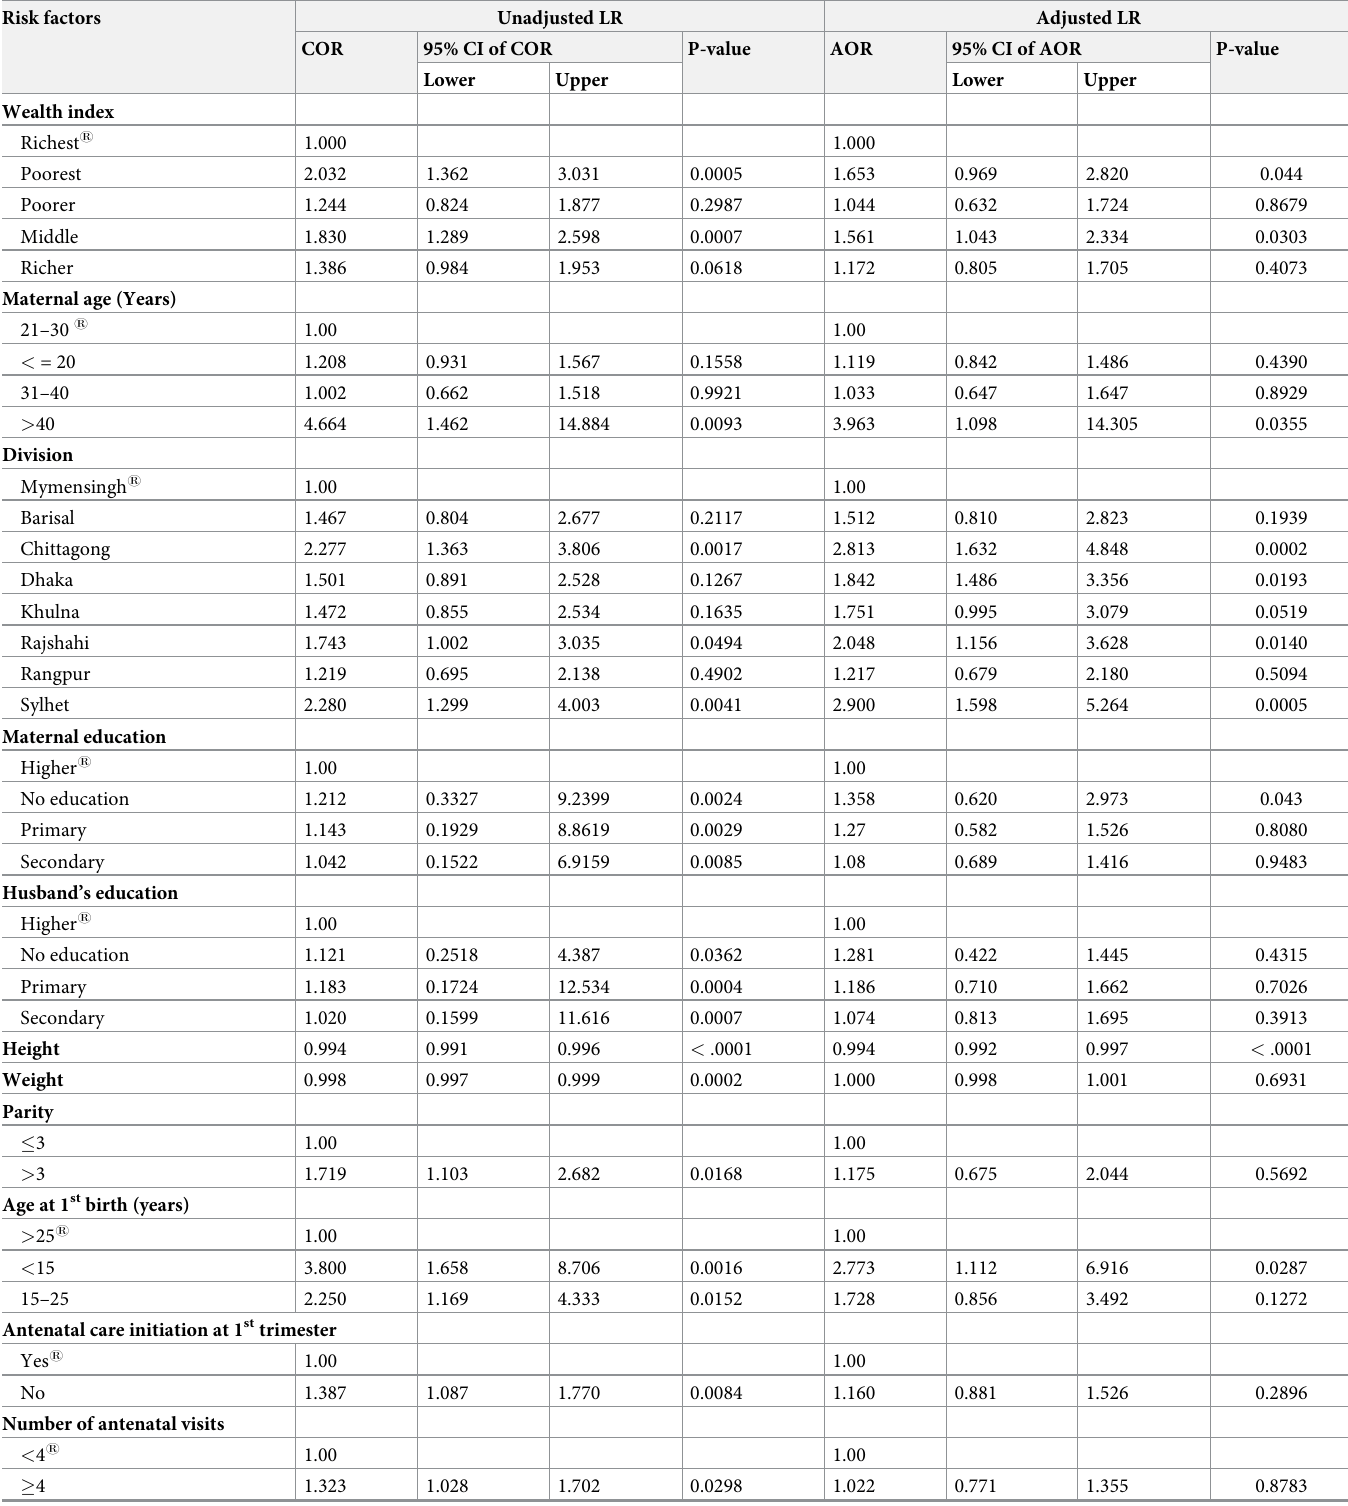
Table 4. Unadjusted and adjusted LR analysis of risk factors for